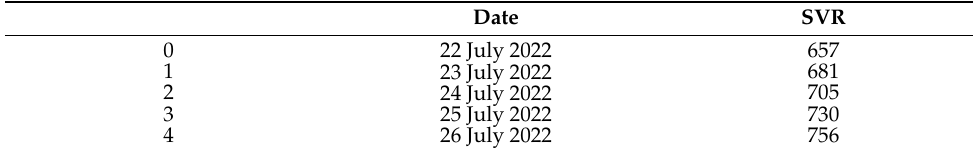
Table 2. SVR model confirmed case prediction for five days.